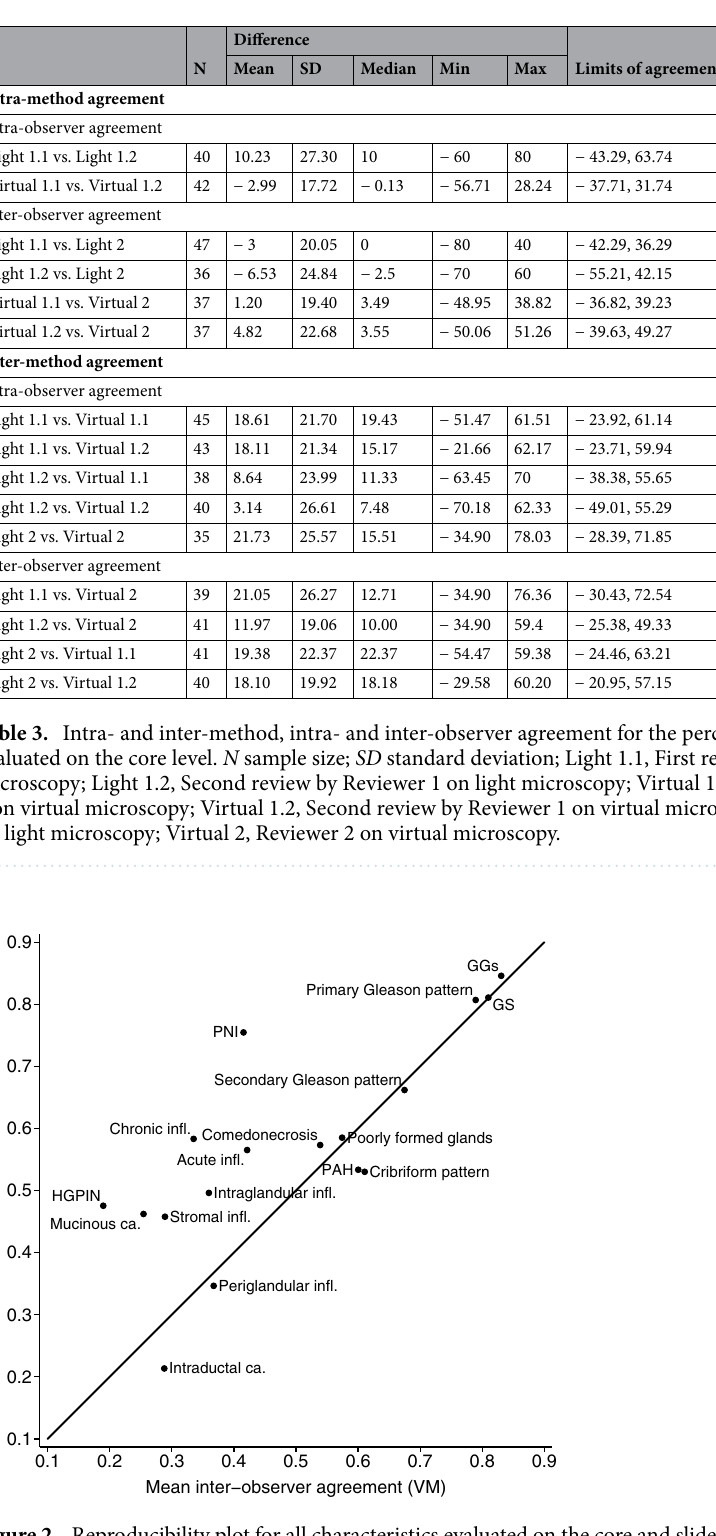
Figure 2. Reproducibility plot for all characteristics evaluated on the core and slide level. Note: Mean inter- observer agreement refers to the mean of the agreements between the Reviewer 1.1 vs. Reviewer 2 and Reviewer 1.2. vs. Reviewer 2. LM light microscopy; VM virtual microscopy; GGs Gleason Grade Groups; GS Gleason score; PNI perineural invasion; PAH Postatrophic hyperplasia; HGPIN High-grade prostatic intraepithelial neoplasia; infl Inflammation; ca